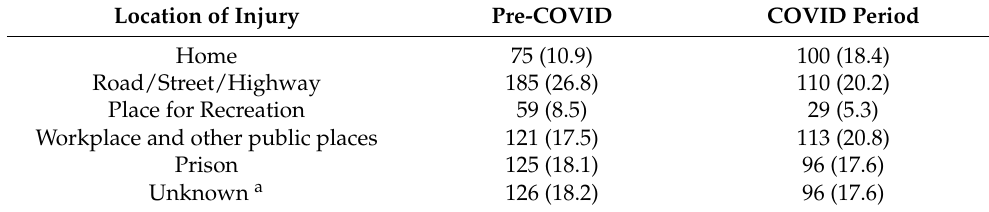
Table 2. Demographic characteristics between COVID periods across all assault subgroups.